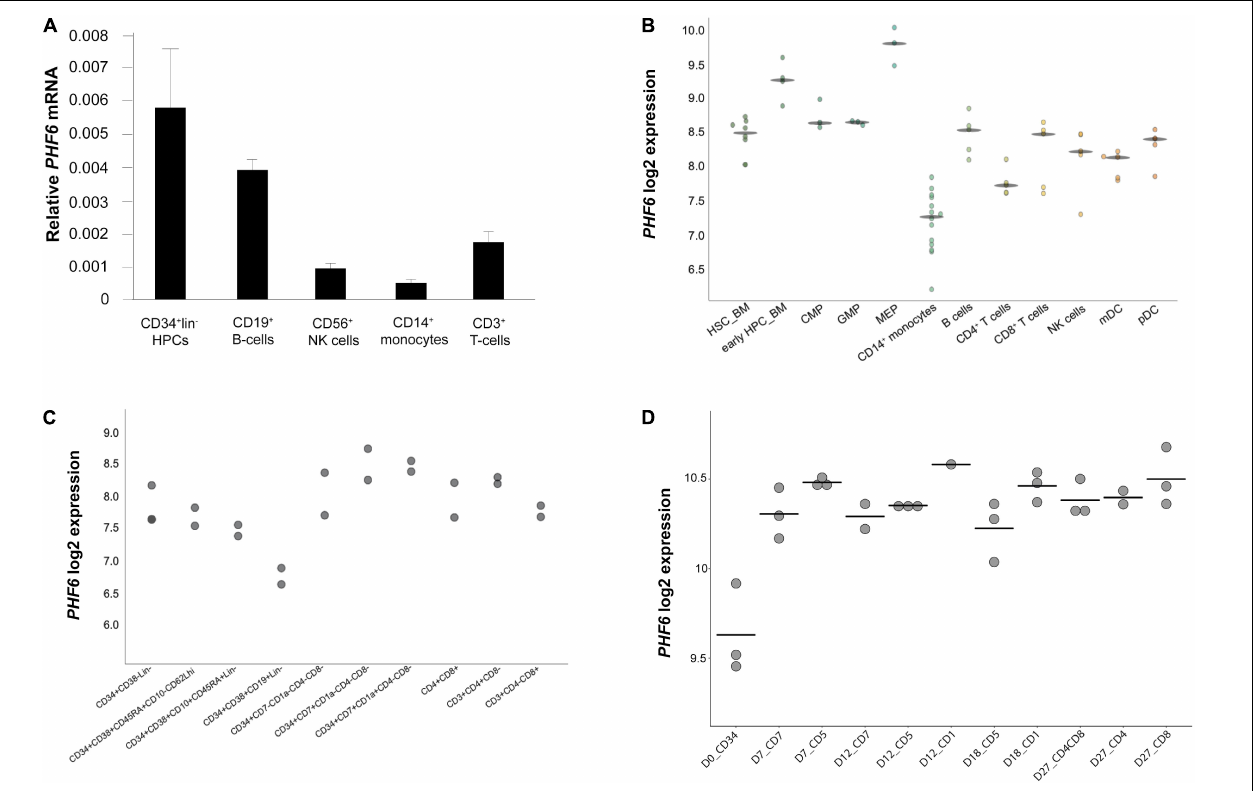
FIGURE 1 | Dynamic PHF6 expression during human hematopoiesis. Relative expression of PHF6 in various hematopoietic cell types: (A) in sorted subsets of human hematopoietic cell lineages, data shows the average of 3–4 independent samples and error bars indicate SEM; (B) adapted from Bloodspot (bloodspot.eu); (C) during human lymphopoiesis (Casero et al., 2015) or (D) during early T lymphoid development in vitro (Canté-Barrett et al.,